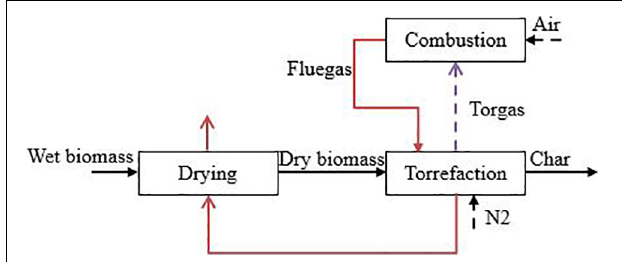
FIGURE 1 | Flow chart of integrated torrefaction